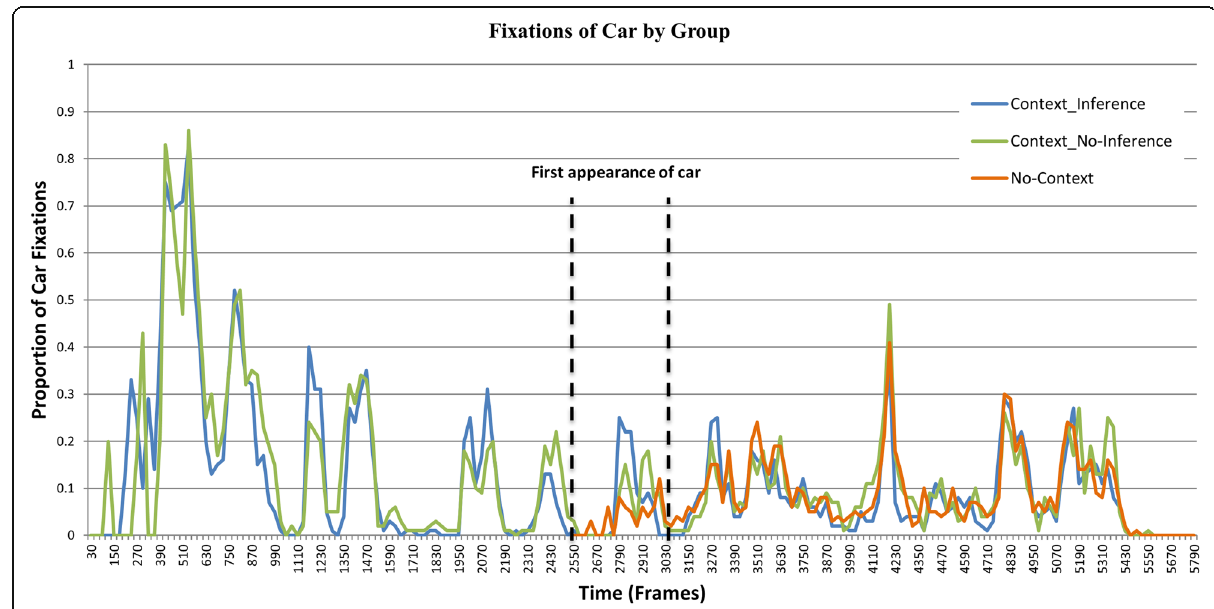
Fig. 5 Proportion of participants fixating the car by context condition and inference throughout the film clip (Context + Inference [ blue ], Context + No-inference [ green ], and No-context+No-inference [ orange ]). The higher the value, the more participants looking at the car. The first appearance of car for No-context group is marked with vertical dotted